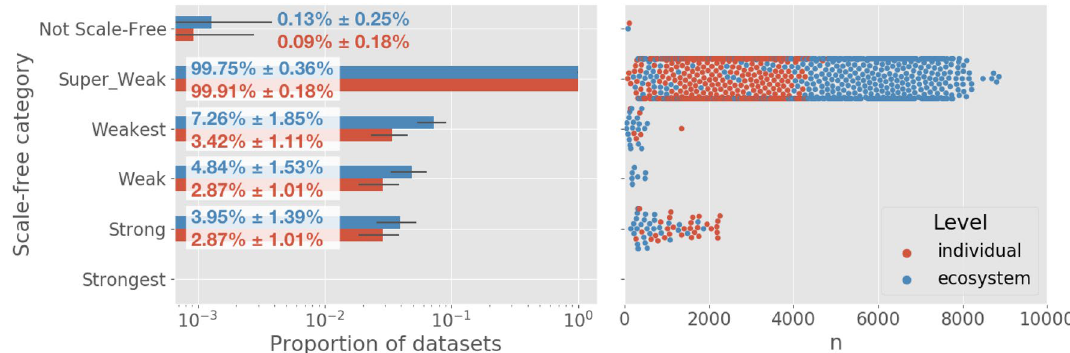
Figure 2. The vast majority of individual and ecosystem level networks are not “scale-free”. Left Most datasets are super weak, indicating that when compared to other models, a power-law distribution is a better fit. However, the power-law distribution is not a “good” fit for most dataset network representations. No networks meet the “Strongest” criteria defined by Broido and Clauset al. 30 . Overlaid values show the percent of networks of each level which fall into each category, ±2SD. Right The relationship between scale-freeness and largest network size across projections ( n ). All datasets containing networks larger than approximately 2100 nodes have degree distributions that rule out fitting well to a